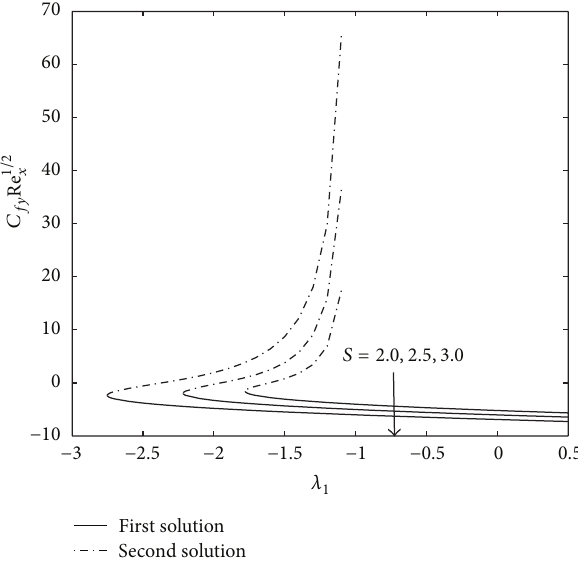
Figure 3: Variation of the skin friction coefficient in 𝑦 -direction with 𝜆 1 for different values of 𝑆 when 𝜆 2 = 1